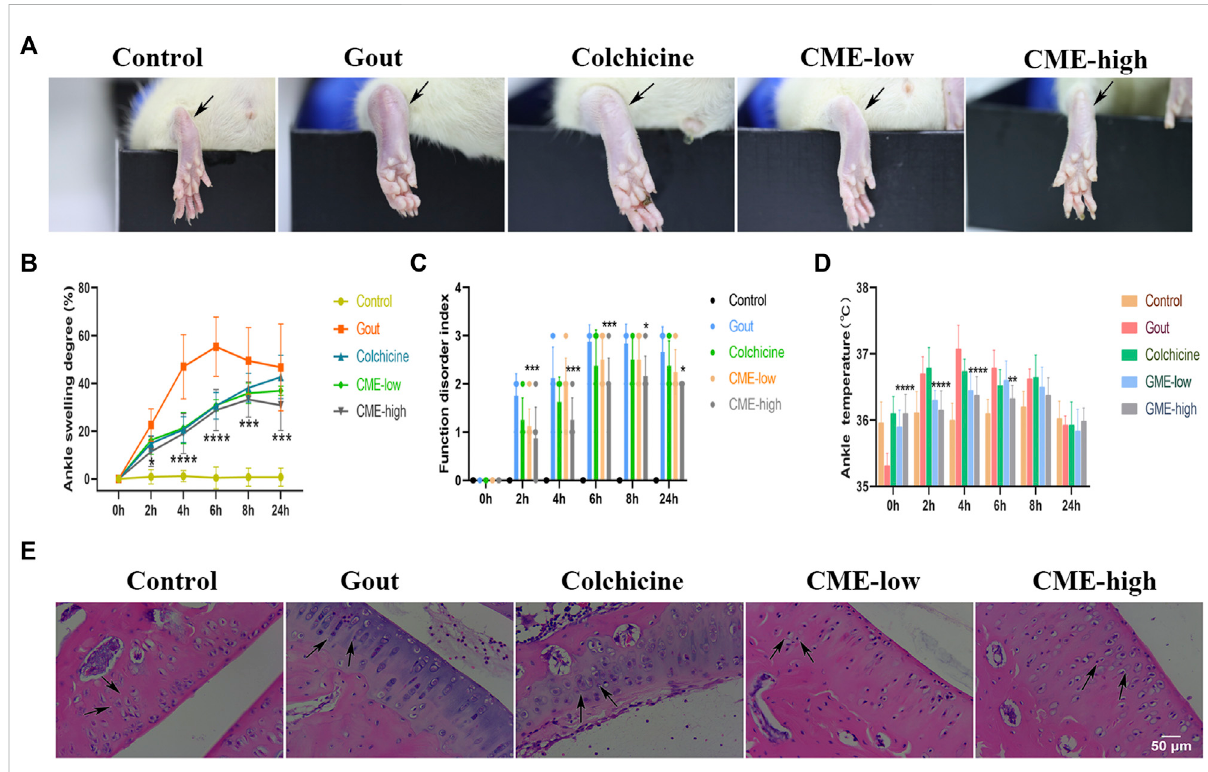
FIGURE 1 The effect of CME on MSU-induced nakedjoints in rats (A) Representative photographs ofthe ankle joints ofrats after 24 hof MSU injection. (B) Ankle girth according to time after MSU crystal injection ( n = 8/group). (C) MSU-induced ankle dysfunction index ( n = 8/group). (D) The mean ankle temperature of MSU-induced gout model ( n = 8/group). (E) Hematoxylin and eosin-stained sections of ankle joints after MSU induction for 24 h (200x). Data are expressed as mean ± SD (two-way ANOVA), * p < 0.05, ** p < 0.01, *** p < 0.001, **** p < 0.0001 vs. Gout.